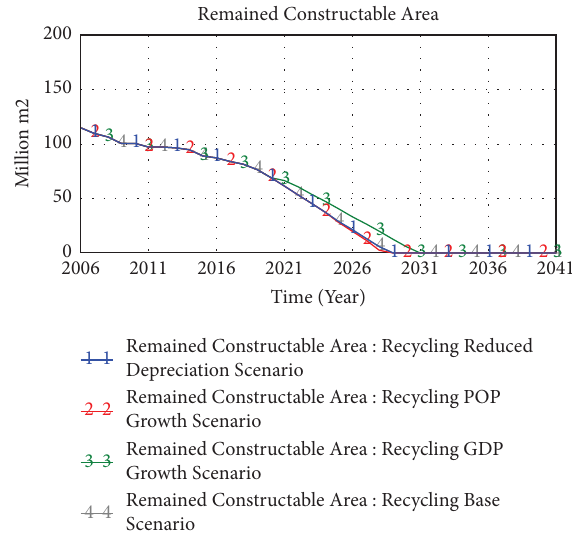
Figure 8: Te variable trend of remained constructable area in the recycling option scenarios.